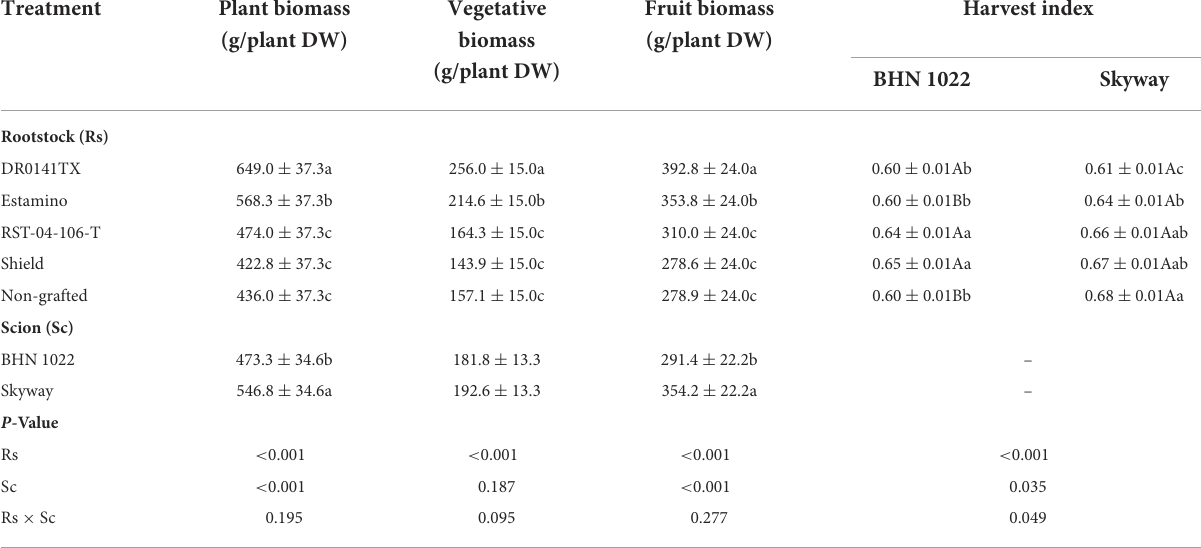
TABLE 4 Plant, vegetative, and fruit biomass, and harvest index (ratio between fruit biomass and plant biomass) of the grafted ‘BHN 1022’ grape tomato and ‘Skyway’ beefsteak tomato scions over the whole production season in the spring planting (14 February to 18 June 2020). Treatment